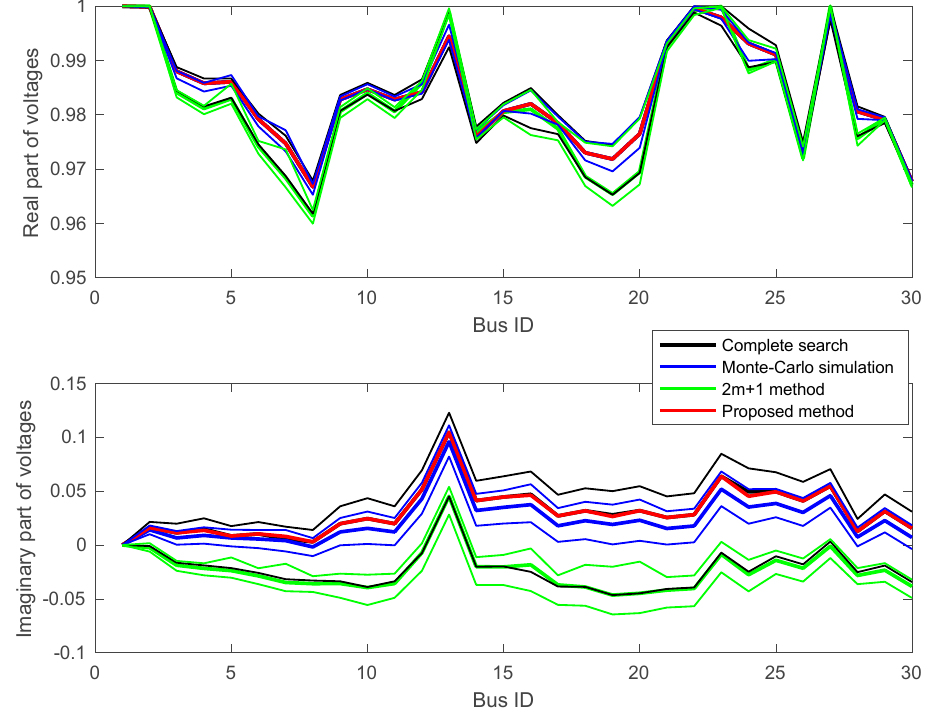
Figure 5. Probabilistic power flow results: (top) real parts of voltages and (bottom) imaginary parts of voltages. Black line: complete search; blue line: Monte Carlo simulation; green line: 2 m + 1 method; and red line: proposed method.